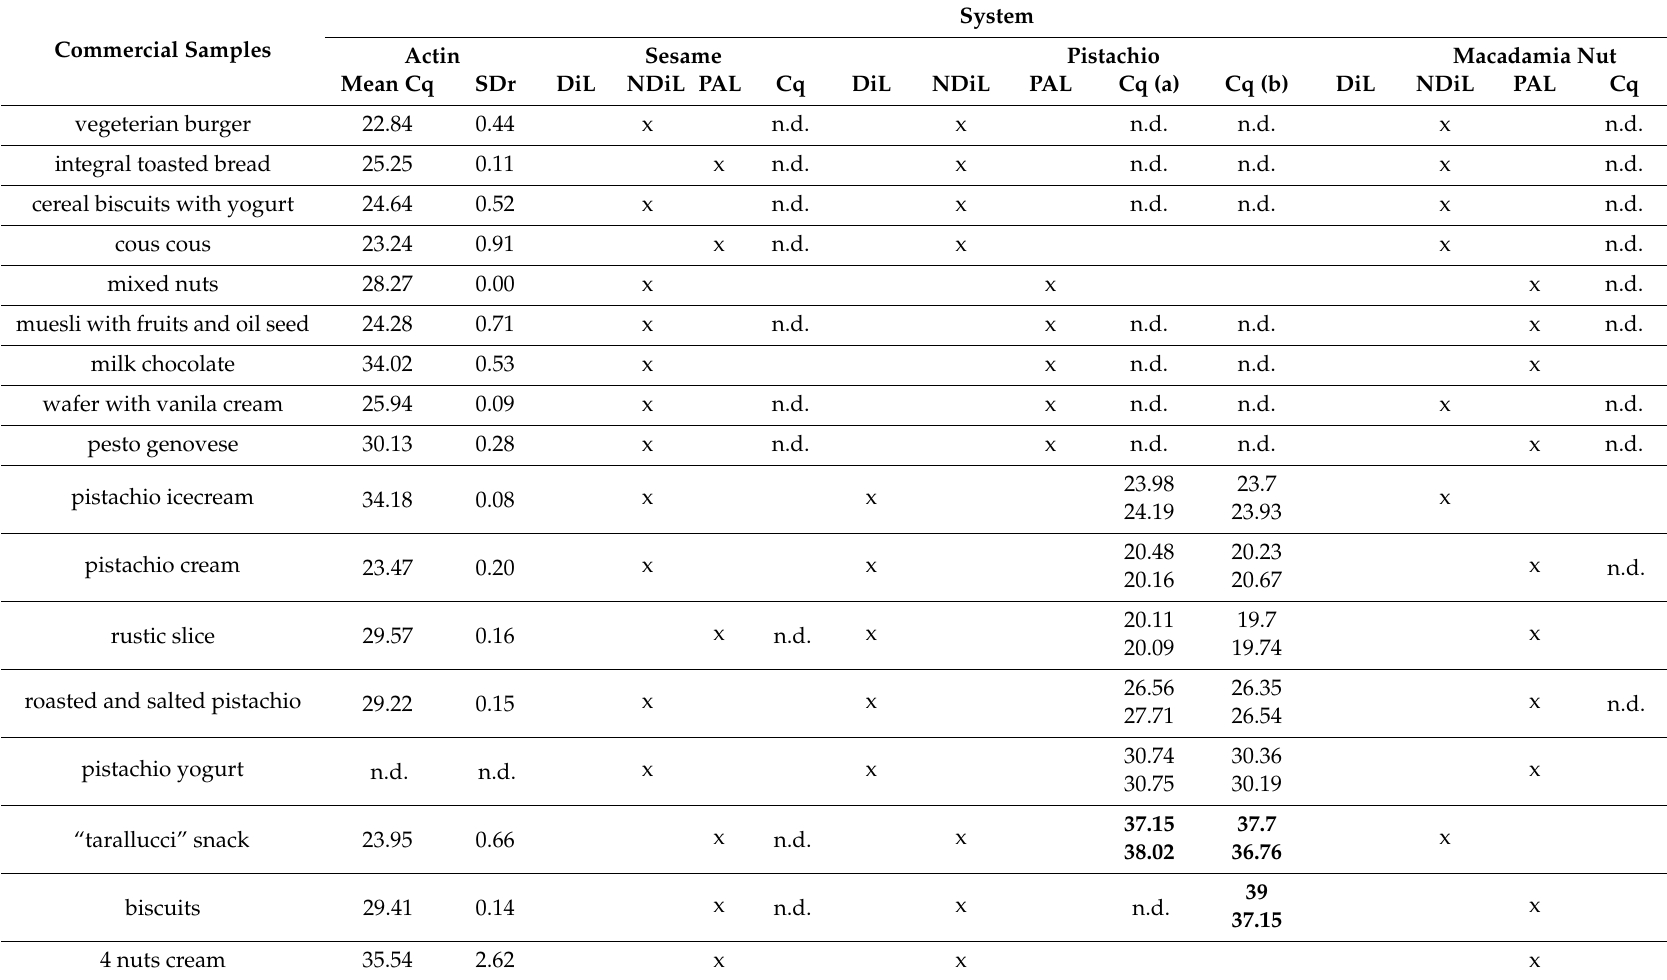
Table 2. Results of analysed commercial food